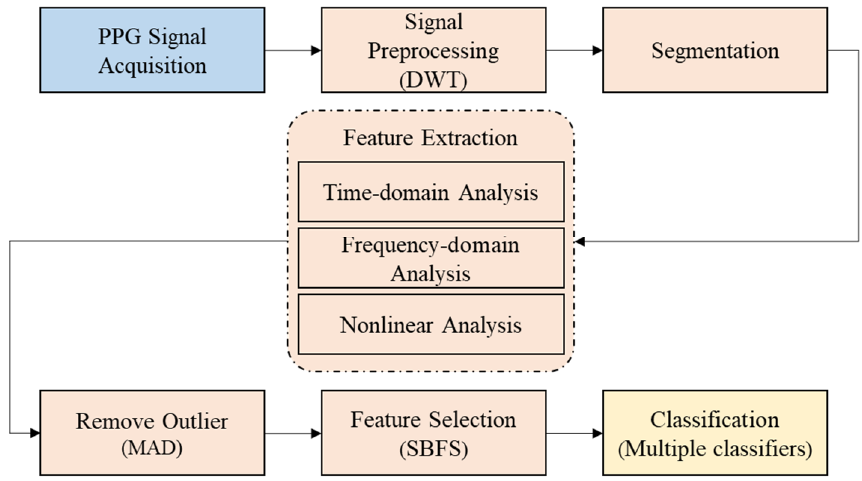
Figure 2. Block diagram of the impulse of love at first sight (ILFS) recognition algorithm.